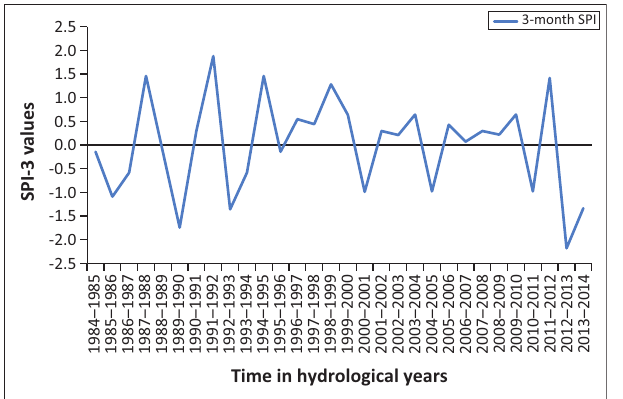
FIGURE 4: Three-month standardised precipitation index: July–September, 1984–2014.